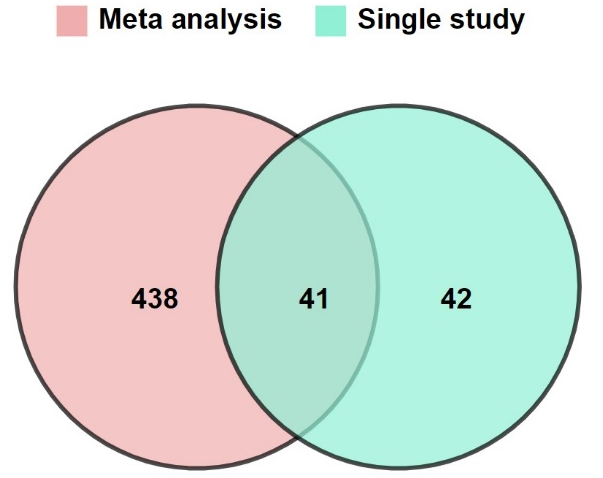
Figure 2. Venn diagram of differential expressed TFs showing the overlap between upregulated transcription factors identified by at least one study and the meta-analysis.